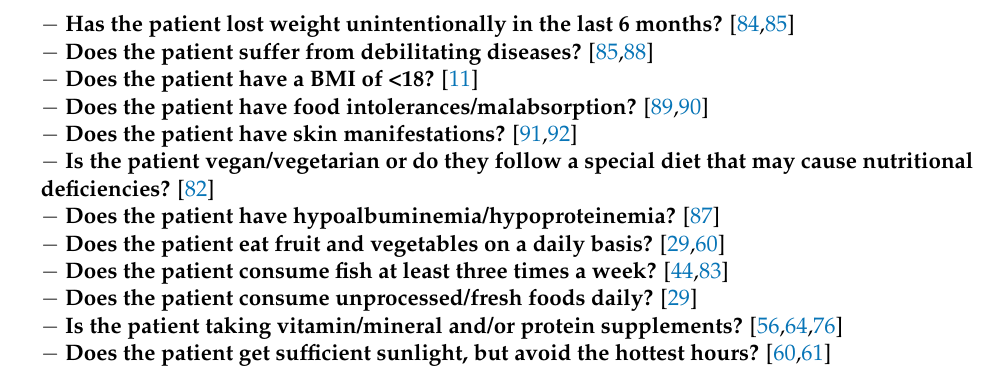
Table 1. Bundle of actions for professionals working in the industry in order to reduce the risks of aesthetic procedures and to improve the clinical